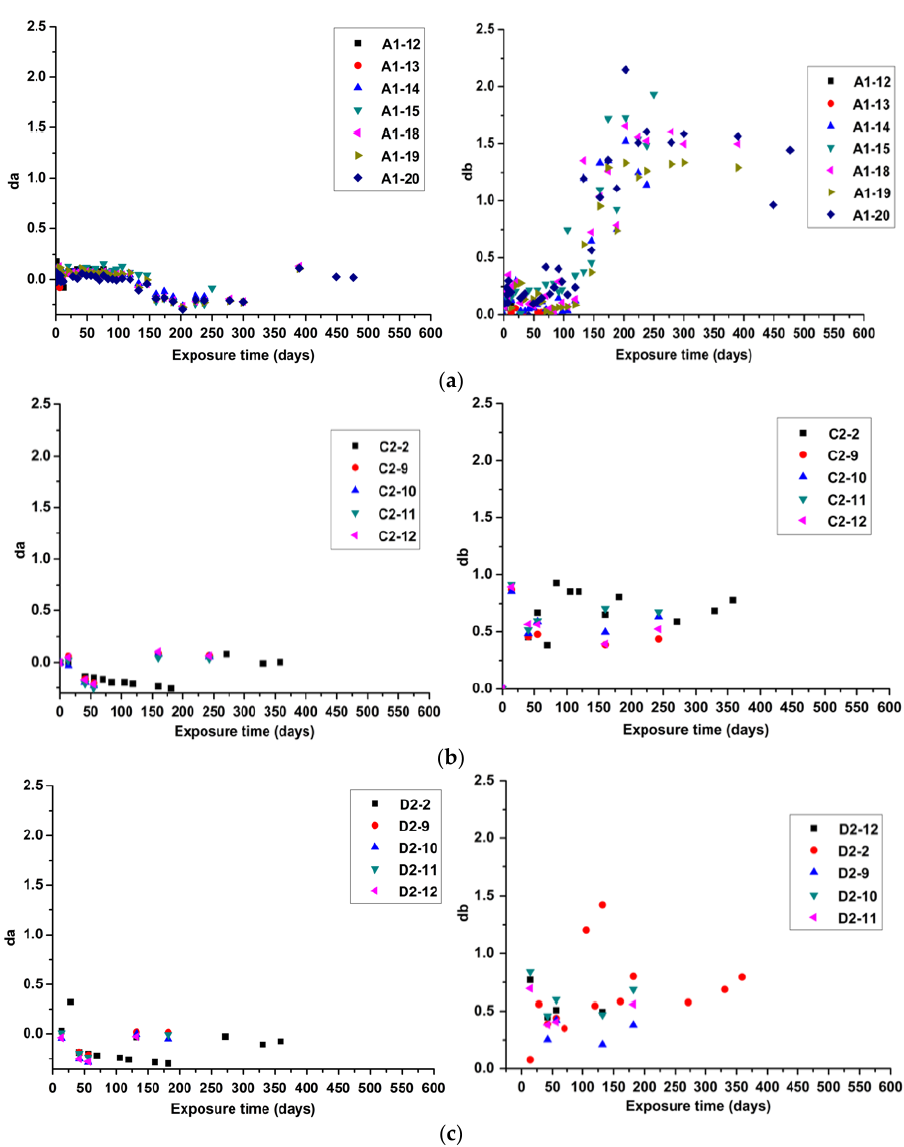
Figure 7. Evolution of color parameters (Δ a and Δ b ) of monolithic mirrors ( a ) A1, ( b ) C2, and ( c ) D2 paint coatings during exposure time at the seaside site.